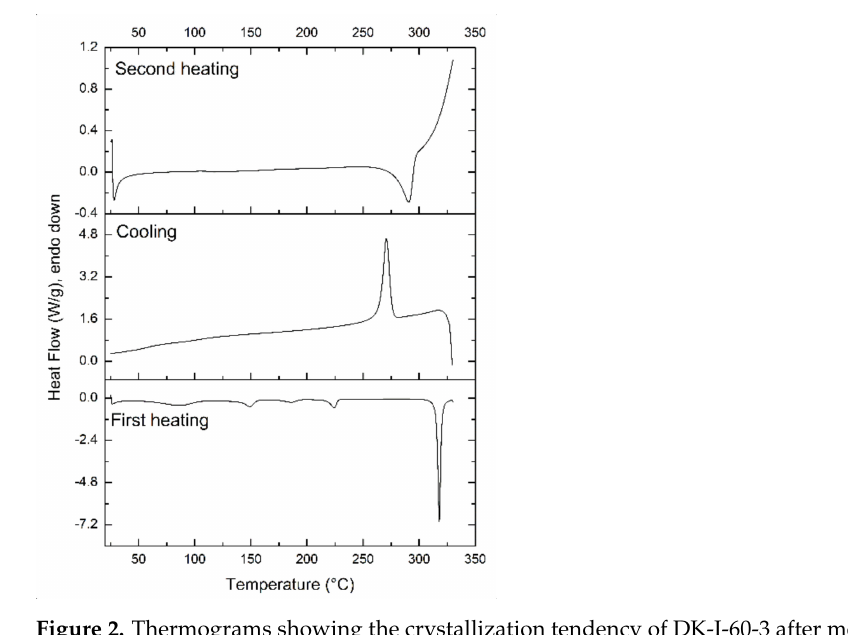
Figure 2. Thermograms showing the crystallization tendency of DK-I-60-3 after melt